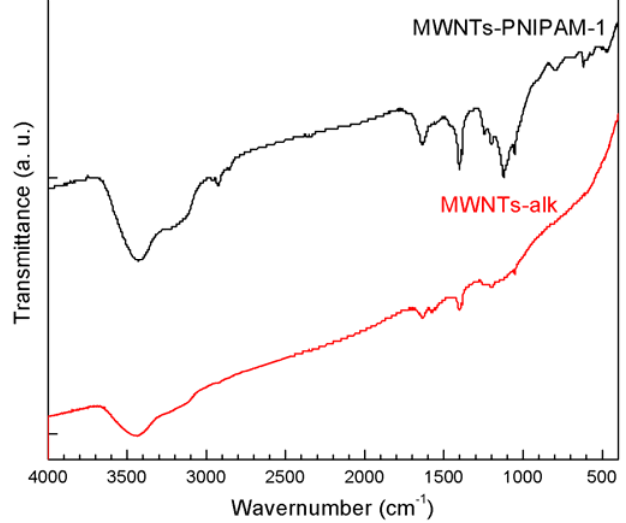
Figure 5. The FT-IR spectra of MWNTs-PNIPAM-1 and